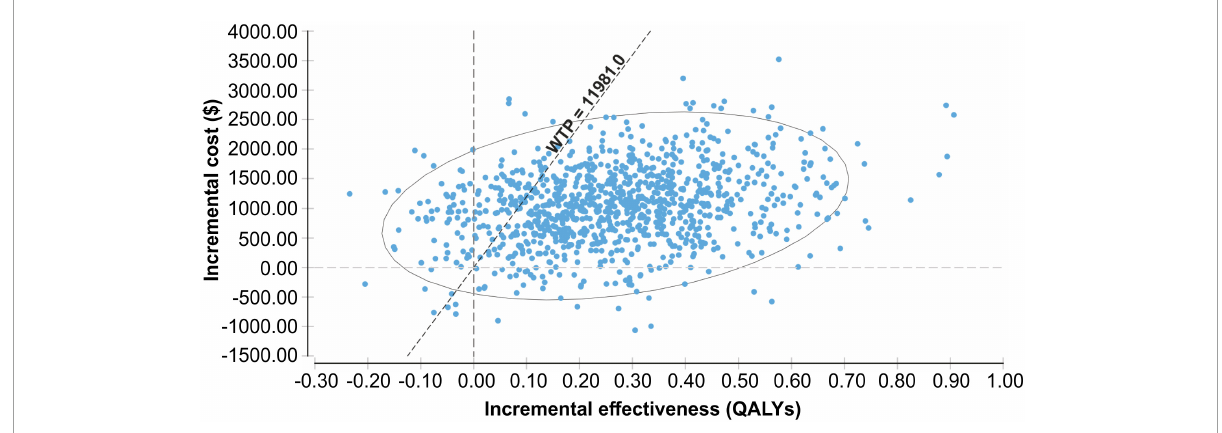
FIGURE3 Scatter plot of the incremental costs and incremental quality-adjusted life-years from a thousand simulations for the empagliflozin group vs. standard